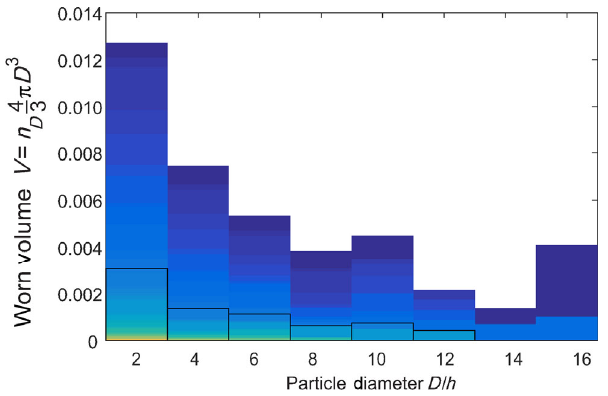
Fig. 8 Histogram of the wear volume of 6986 particles as a function of the particle size (given in terms of the computational grid spacing  ). No particle larger than 16   D occurred. Different colors mark different force levels up to 1 2   p , see the black boxed series for instance, other parameters as in Fig.